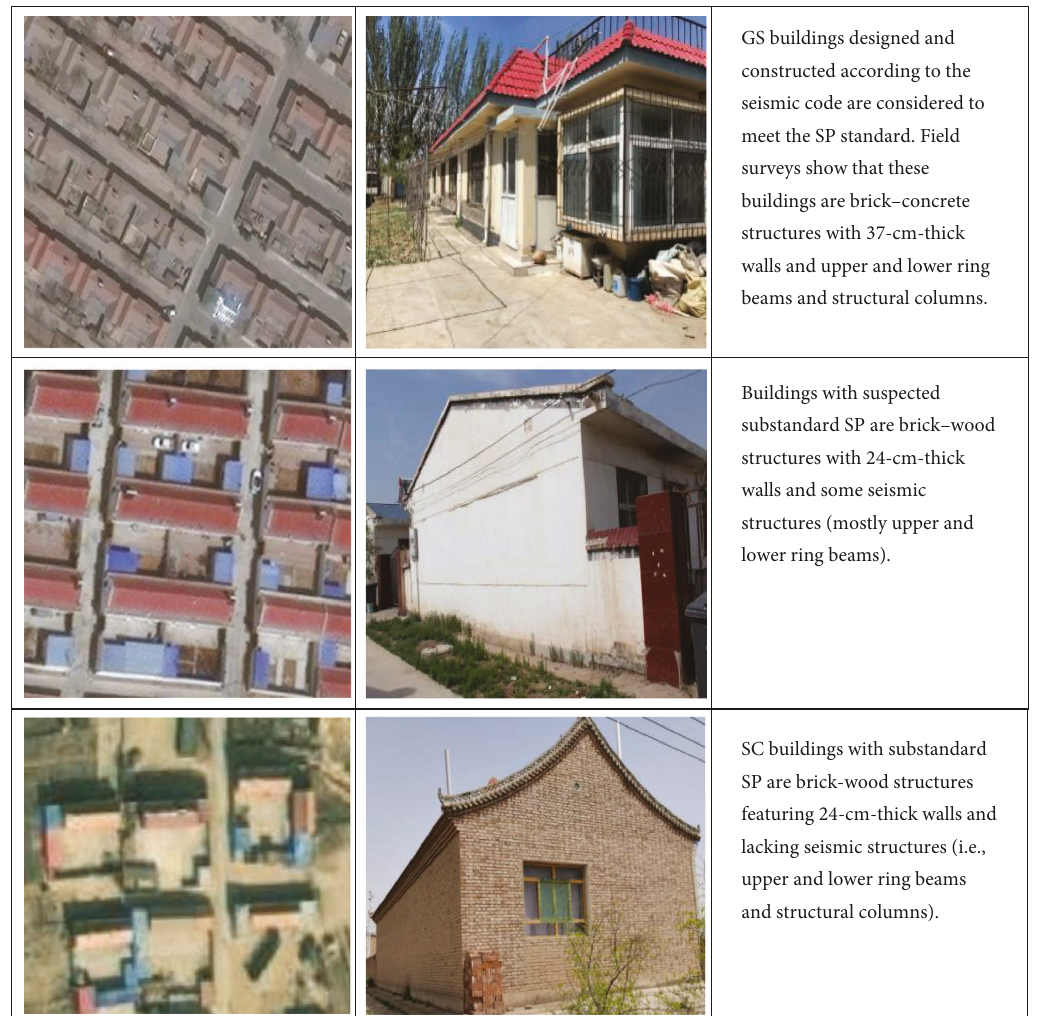
Figure 4: Typical buildings in rural and RUF